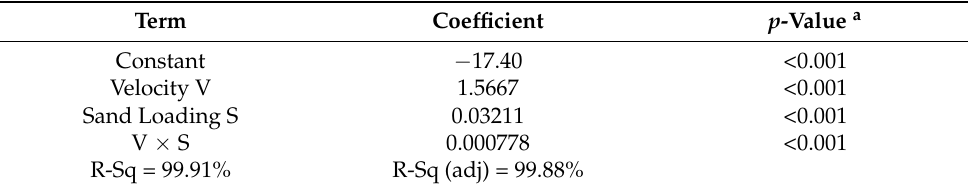
Table 7. Regression analysis for E 0